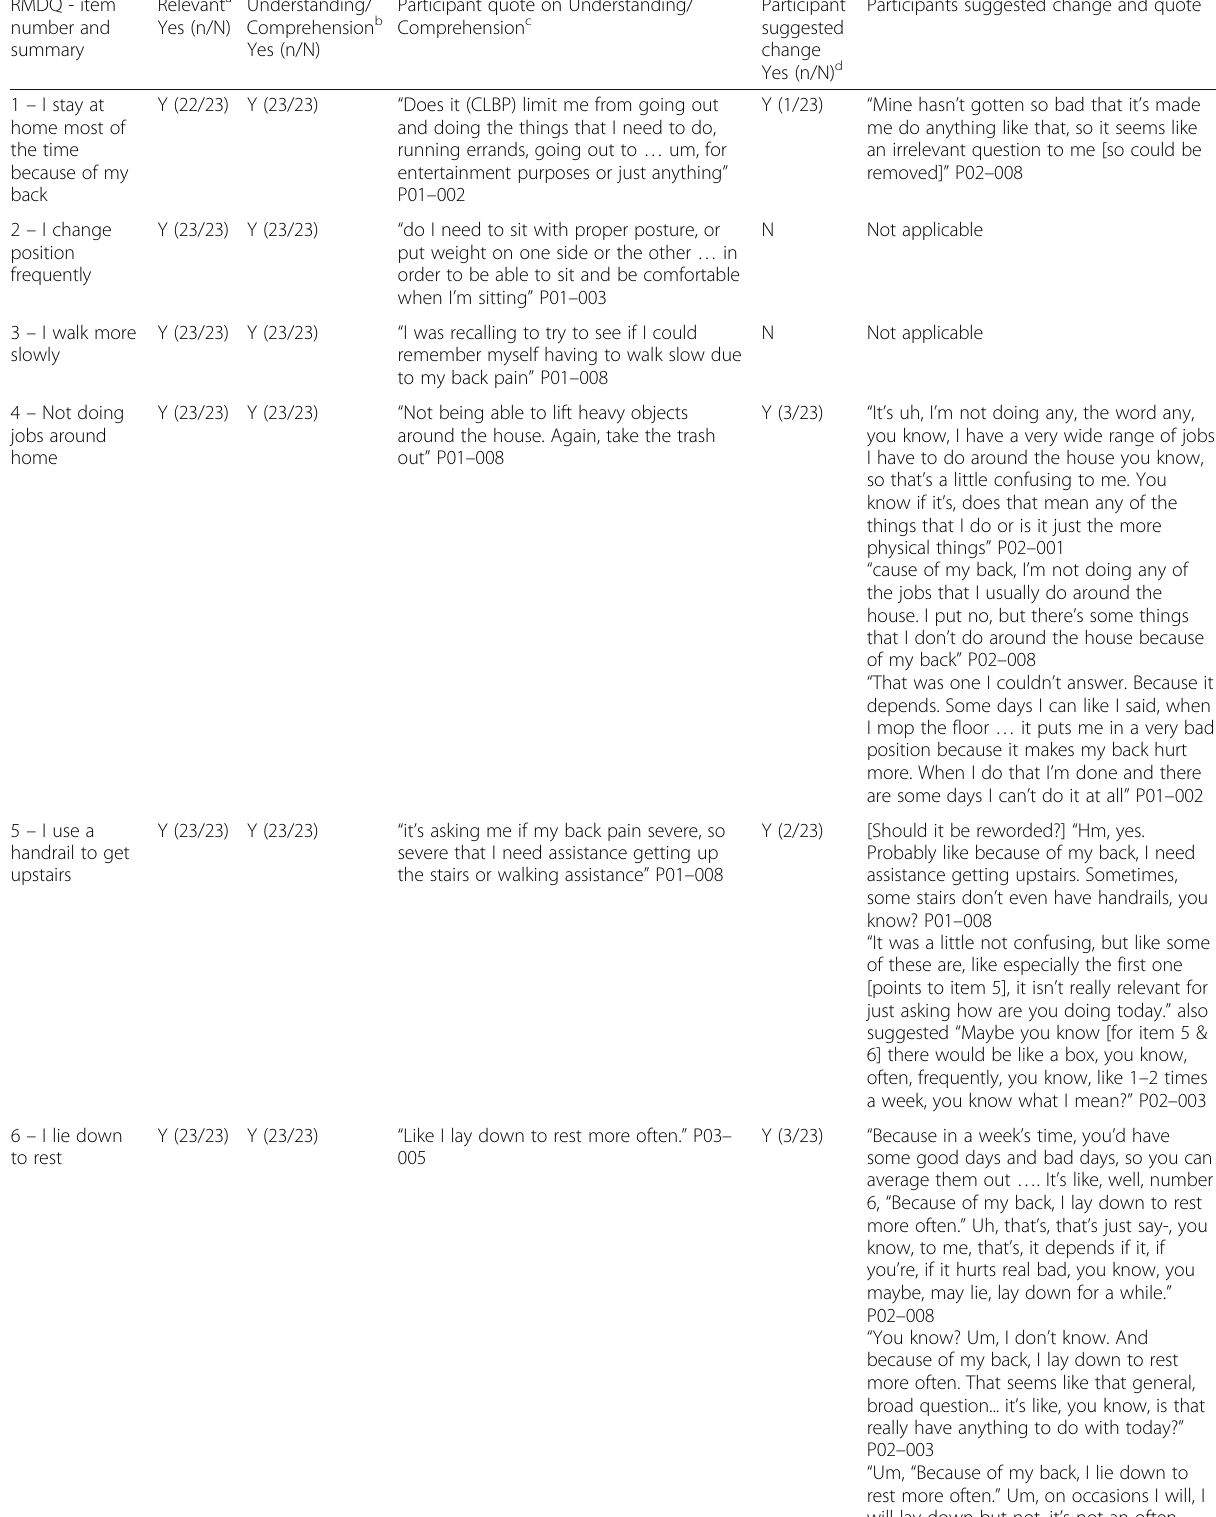
Table 4 Item relevance and participants ’ suggested